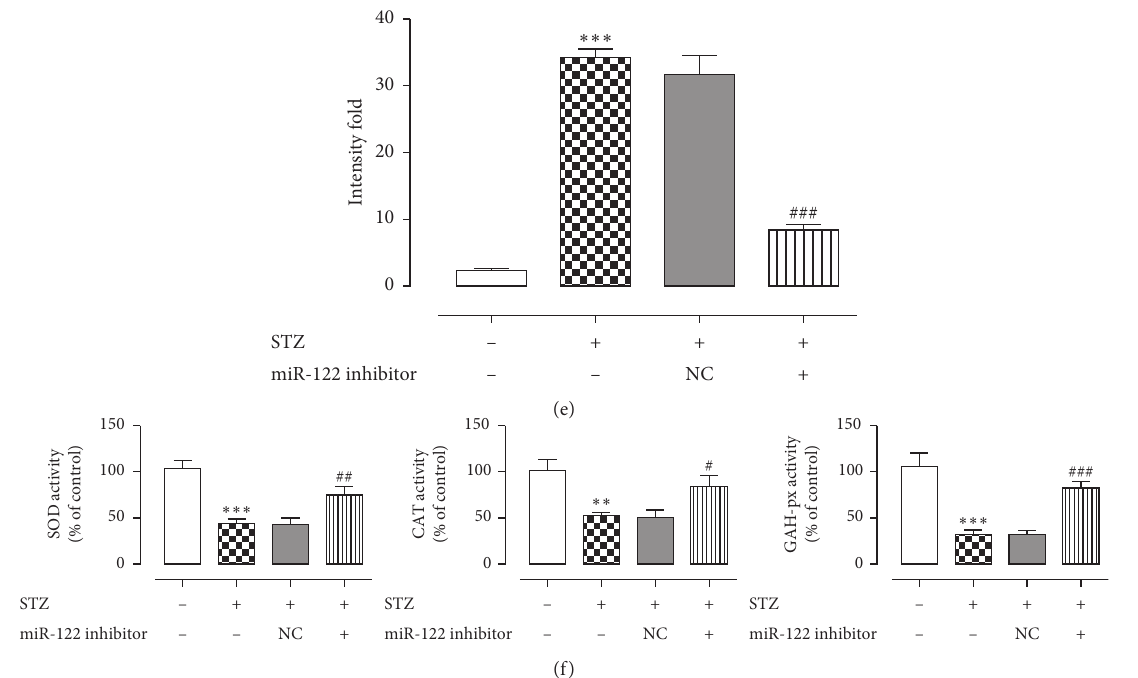
Figure 1: MiR-122 participates in the oxidative stress in STZ-induced pancreatic β cells. (a) The expression level of miR-122 in INS-1 cells detected by RT-qPCR. (b) Detection of the expression level of miR-122 after adding miR-122 inhibitor. (c) ELISA kit detects Insulin content. (d, e) Detection of the intracellular ROS level. (f) Detection of oxidative stress level in cells. ∗ P < 0 . 05, ∗∗ P < 0 . 01, ∗∗∗ P < 0 . 001 versus control group; # P < 0 . 05, ## P < 0 . 01, ### P < 0 . 001 versus STZ group. The experiment was repeated three